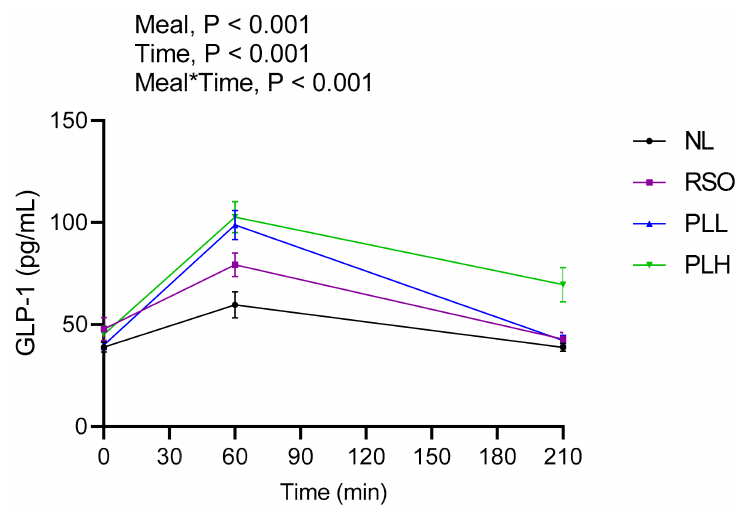
Figure 7. Mean concentrations of GLP-1 after the breakfast meal. Values are means ± SEM, n = 20 healthy subjects. Repeated measures; mixed model in SAS. NL, oat preparation without added lipids; RSO, oat preparation added with rapeseed oil; PLL, oat preparation with a low concentration of polar lipids; PLH, oat preparation with a high concentration of polar